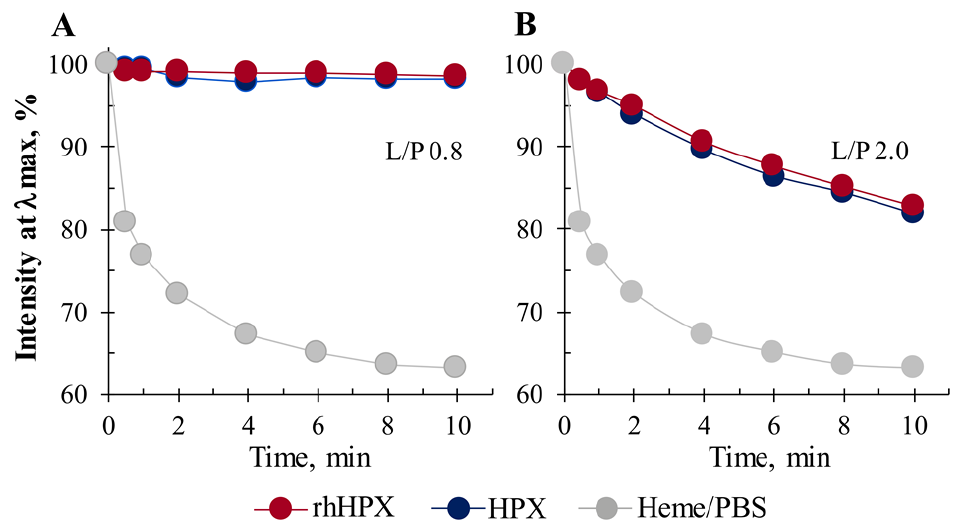
Figure 6. UV-Vis time-course measurements of heme complexes with plasma HPX and rhHPX in the presence of H 2 O 2 (8-fold molar excess over the protein/heme complex) at an L/P of 0.8 ( A ) and 2.0 ( B ) versus heme in PBS alone.